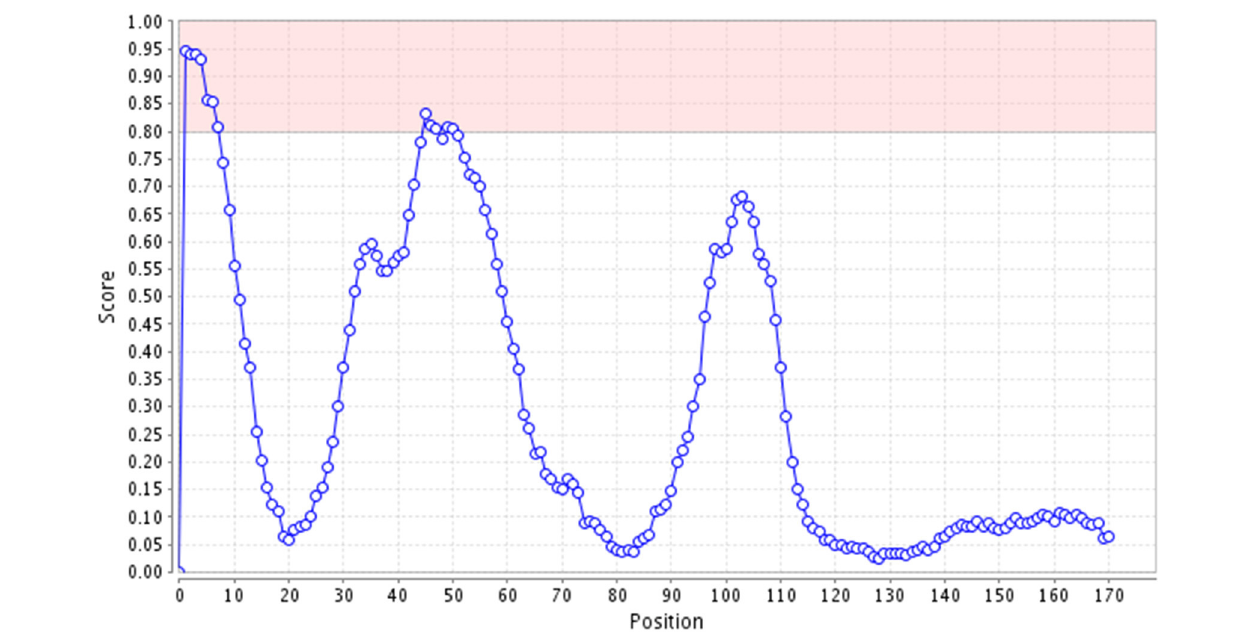
FIGURE 5 | Predicted Nucleolar localization sequences in HCV core protein. Graph obtained from the Nucleolar Localization Sequence detector web server (NoD), displaying NoLS prediction score for each residue of HCV Core protein. Pink shaded regions represent the range of scores within which a 20-residues segment is predicted to be a NoLS. Thus, pink shaded regions represent the NoLS candidate segment, which highlights scores above 8.0.